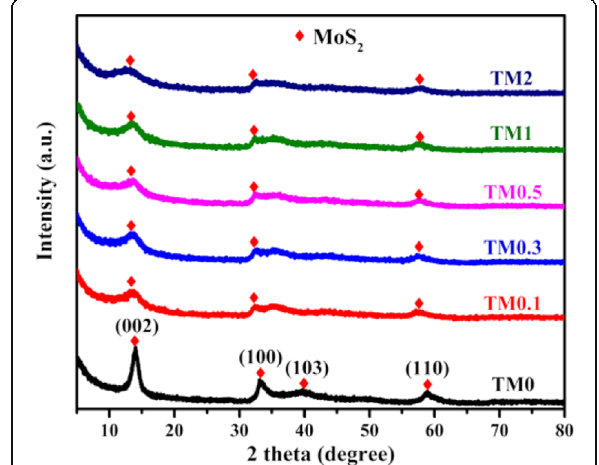
Fig. 1 XRD patterns of TM0, TM0.1, TM0.3, TM0.5, TM1, and TM2